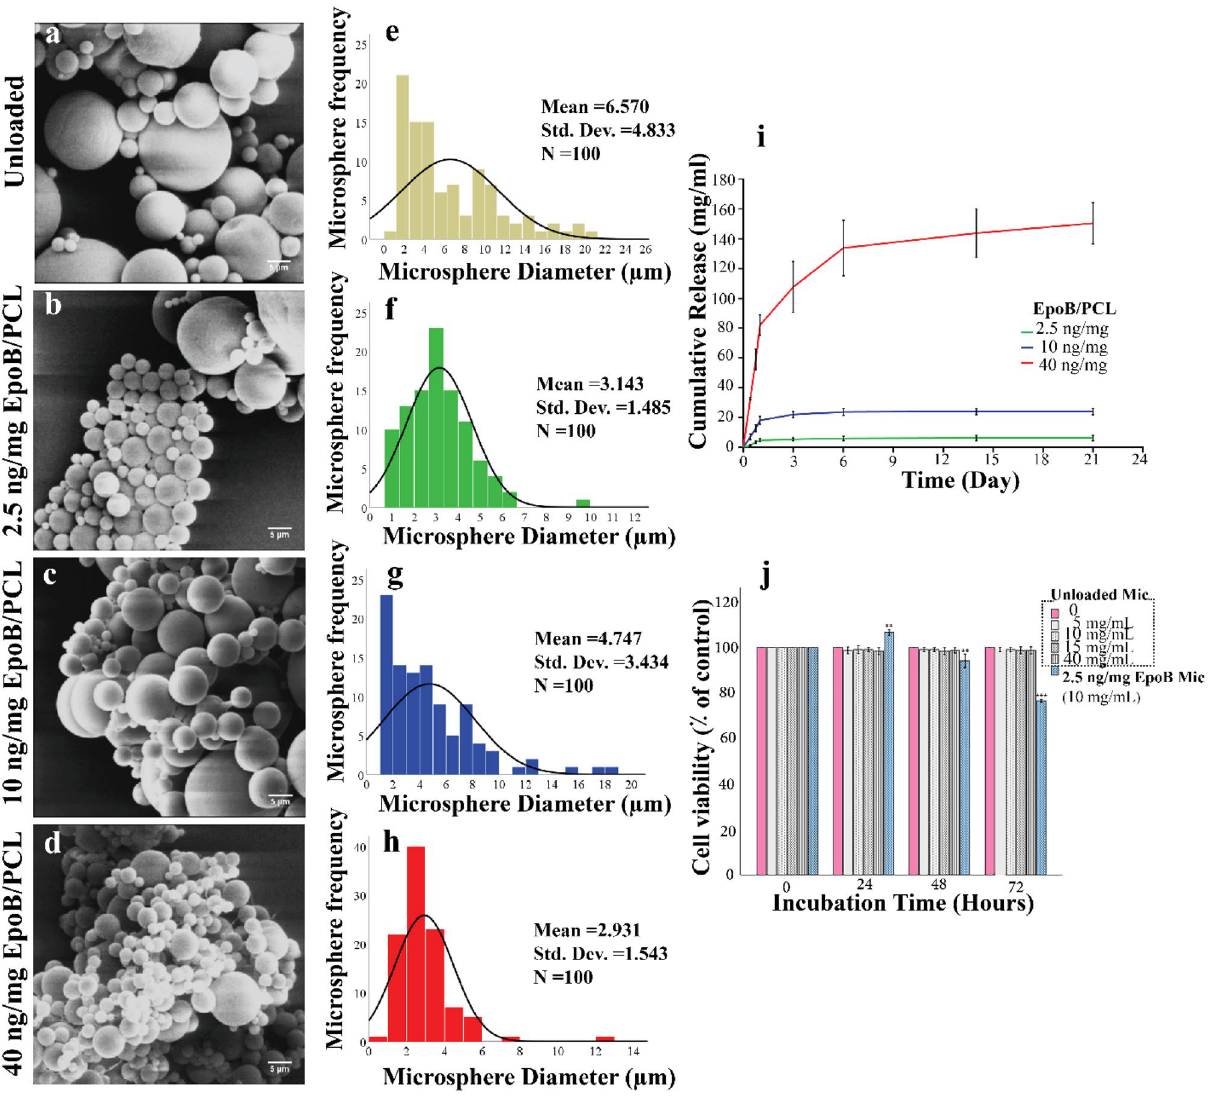
Figure 3. Characterization of microspheres. Scanning electron microscopy (SEM) and characterization of unloaded, 2.5, 10, and 40 ng/mg EpoB/PCL microspheres. ( a – d ) SEM shows smooth morphology and some microsphere clustering. ( e – h ) Particle size distribution histogram indicating expected particle size diameters (Sample size n = 100). ( i ) The cumulative release profile of 2.5, 10, and 40 ng/mg EpoB/PCL microspheres over 21 days (7-time points). Sample size n = 3. ( j ) The effect of 2.5 ng/mg EpoB Mic and different concentrations of PCL microspheres (unloaded Mic) on cell viability of hEnScs. Data are displayed as the percentage of cell viability in three independent tests, with each test having three individual samples. Cell viability graphs were compiled using SPSS 21 (clustered bar, summaries for groups of cases). (Error bars: ± 1 SD). P values were assessed with SPSS 21, using one-way ANOVA and DUNNETT test. The effect of all samples was compared to 0 (control). *P < 0.05, **P < 0.01, ***P < 0.001.